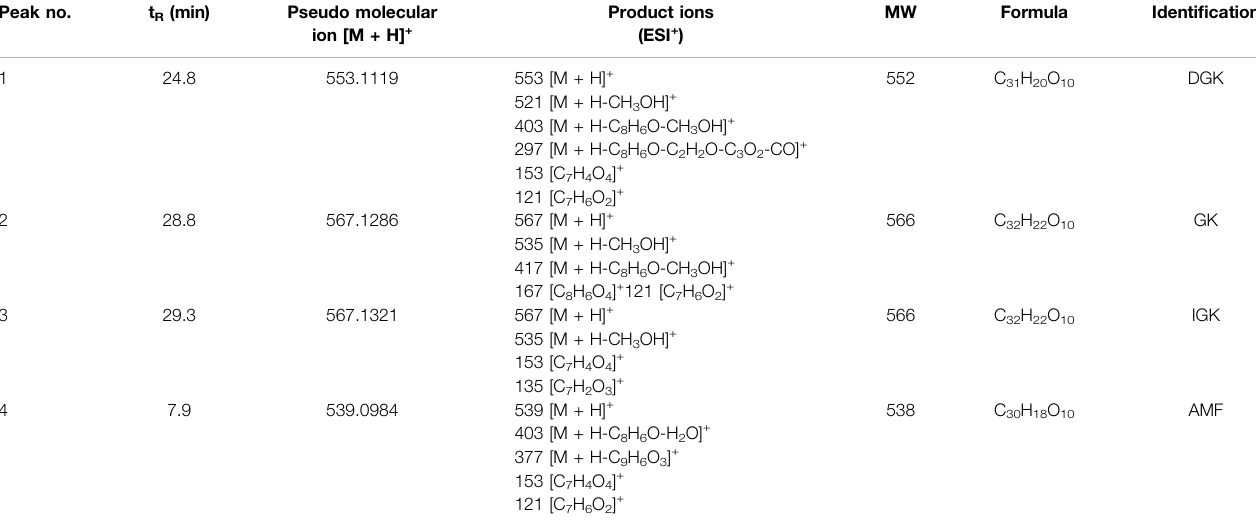
TABLE 1 | Identi fi cation and characterization of inhibitory components with potent CYP3A4 inhibitory effects in GB and ST. Peak no.